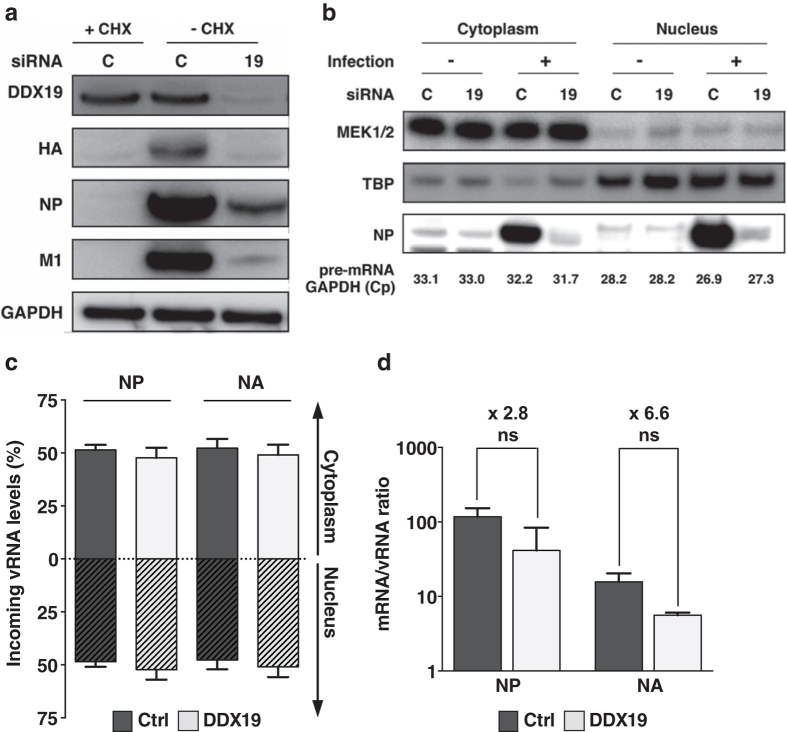
The earliest steps of IAV replication are not affected by DDX19 depletion.A549 cells treated with control (C in a and b, dark grey bars in c and d) or DDX19 (19 in a and b, light grey bars in c and d) siRNAs were infected with WSN (5 pfu/cell). (a) Total extracts from control cells treated with CHX (+CHX) or not (−CHX) were prepared at 6 hpi and analyzed by immunoblots using antibodies directed against the indicated proteins. Cropped blots are shown. The corresponding full-length blots are shown in Figure S4. (b) Cytoplasmic and nuclear fractions were prepared at 4 hpi. Aliquots of the indicated subcellular fractions were analyzed by immunoblots with antibodies directed against MEK1/2 kinase (cytoplasmic marker), TBP (nuclear marker) and NP. Alternatively, total RNAs were extracted and the levels of GAPDH pre-mRNA, a nuclear marker, were determined by real-time RT-PCR. Results are expressed as the mean of two determinations of the crossing point value (Cp). Cropped blots are shown. The corresponding full-length blots are shown in Figure S5. (c,d) Infection was carried out for 6 h in the presence of CHX (100 µg/mL). Total RNAs were isolated from cytoplasmic (solid bars) and nuclear (hatched bars) fractions, and the levels of NP and NA vRNAs were determined by strand specific RT-qPCR. The results are expressed as the mean percentages ± SEM of cytoplasmic and nuclear vRNAs levels determined in three independent experiments (c). Total RNAs were extracted and the levels of NP or NA mRNAs and vRNAs were determined by strand specific RT-qPCR. The results are expressed as the mean ratios of mRNA/vRNA ± SEM determined in three independent experiments (d).